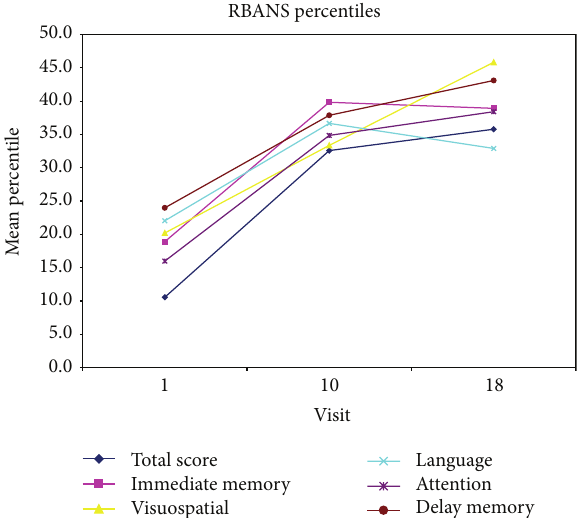
Figure 2: This figure illustrates changes in Repeatable Battery for the Assessment of Neuropsychological Status percentile scores over time.